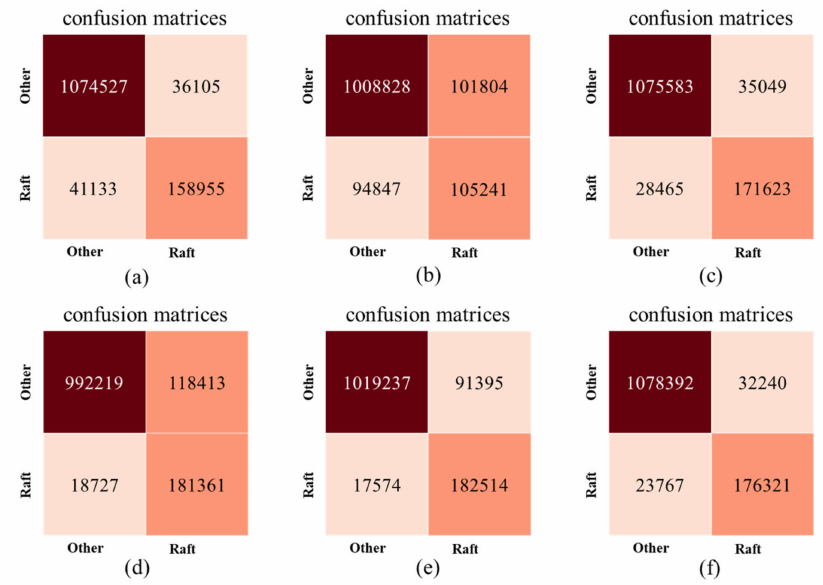
Figure 8. Confusion matrices of accuracy evaluation. ( a – f ) represent the results of FCN, SegNet, UNet, UNet++, ResUNet, and RaftNet, respectively. The columns represent the true label and the rows represent the extracted label. The first column of the first row indicates TN, the second column of the first row indicates FP, the first column of the second row indicates FN, and the second column of the second row indicates